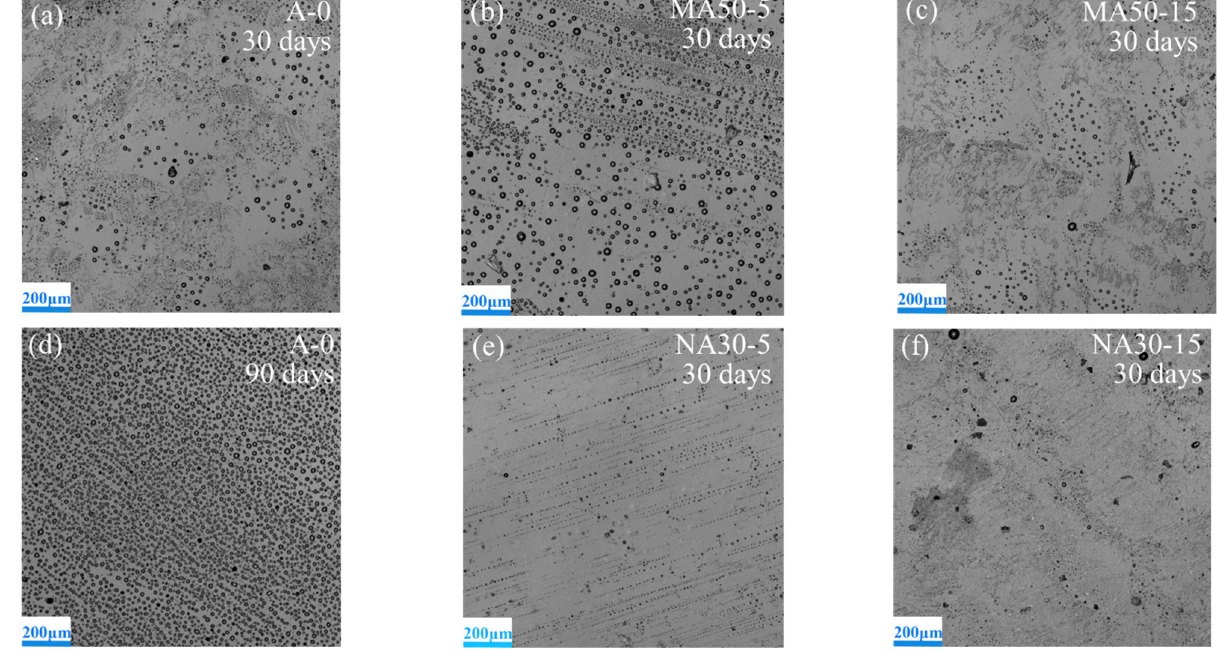
Figure 5. CLSM images of the coatings after exposure in air: ( a ) A-0 30 days, ( b ) MA50-5 30 days, ( c ) MA50-15 30 days, ( d ) A-0 90 days, ( e ) NA30-5 30 days, ( f ) NA30-15 30 days.